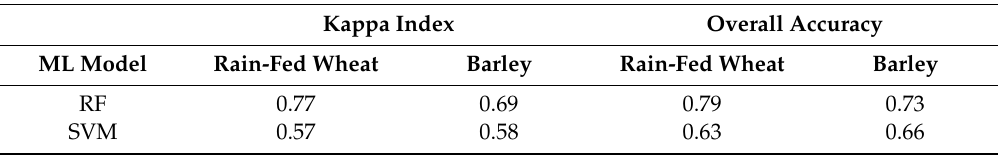
Table 3. Error criteria for prediction of land suitability class (SVM: support vector machine; RF: random forest) based on 10-fold cross